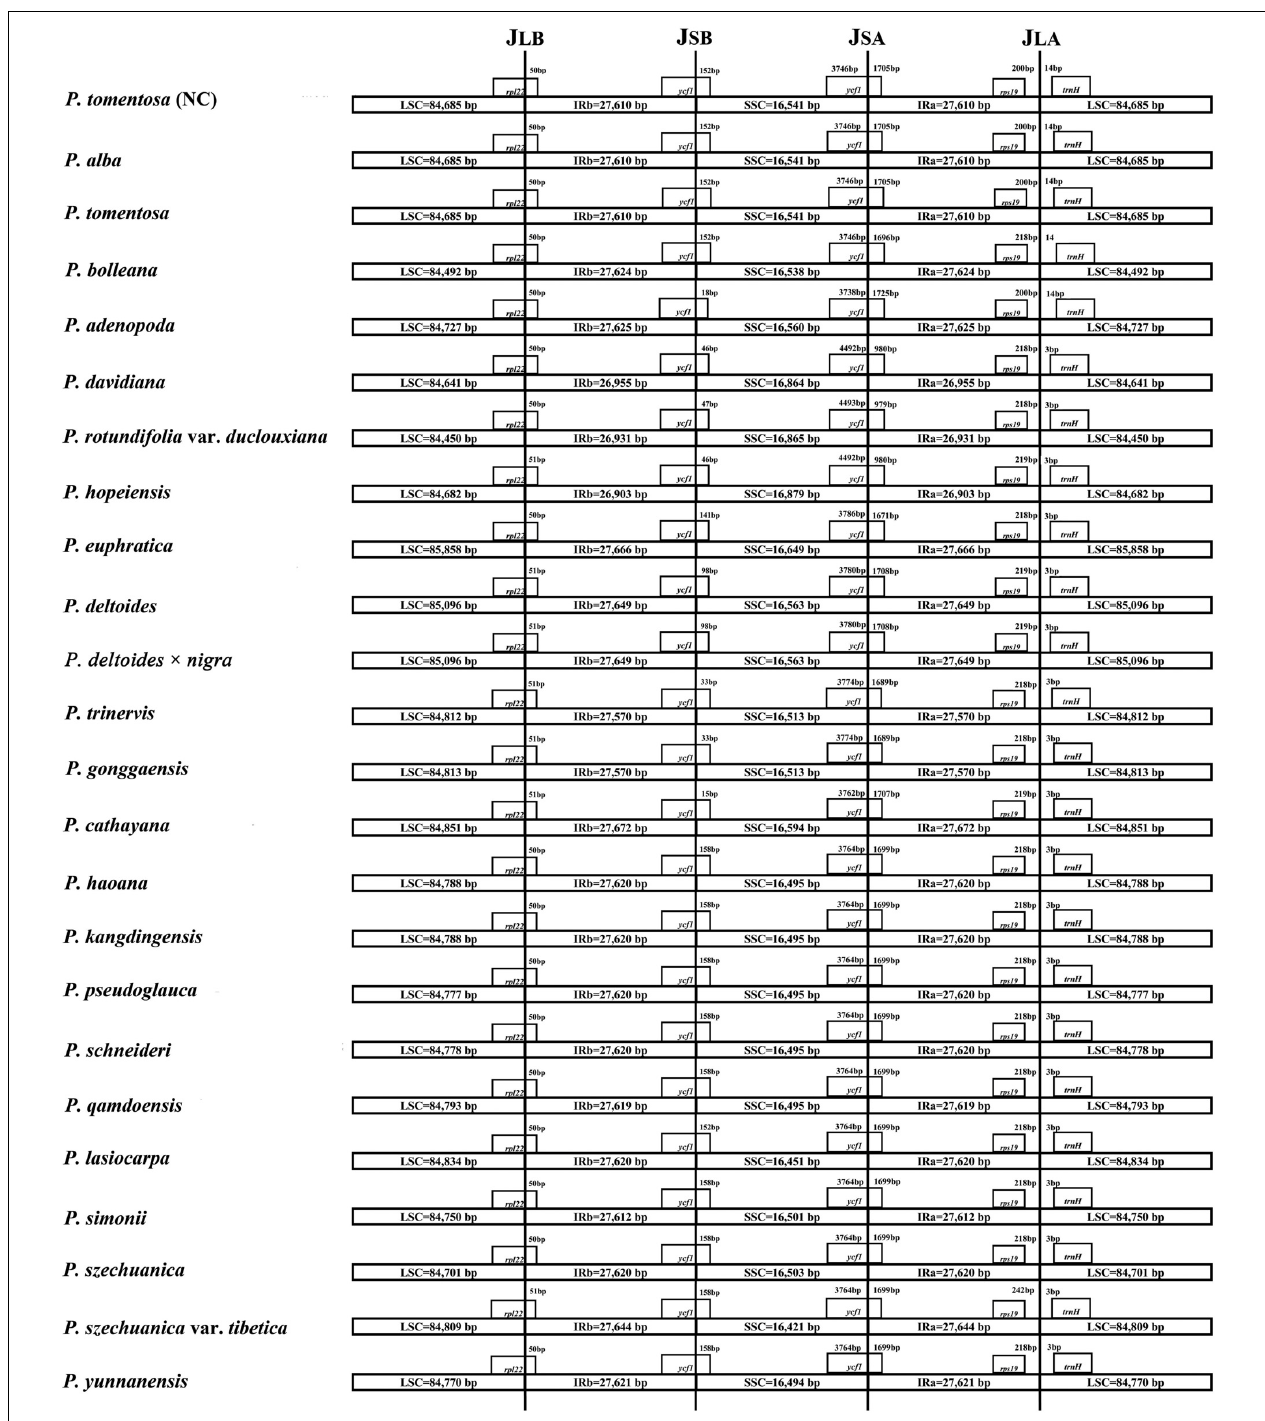
FIGURE 2 | Comparison of the borders of the LSC, SSC, and IR regions of 24 Populus plastomes.